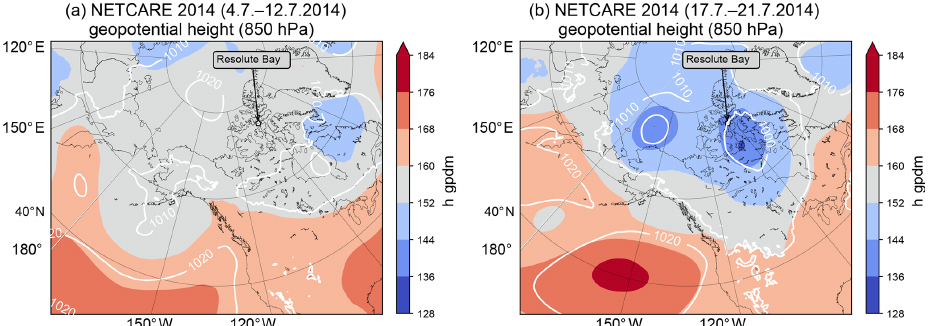
Figure 2. Mean geopotential height at 850hPa in geopotential decameters (gpdm) for the period from 4 to 12 July 2014 (a) and for the period from 17 to 21 July 2014 (b) .